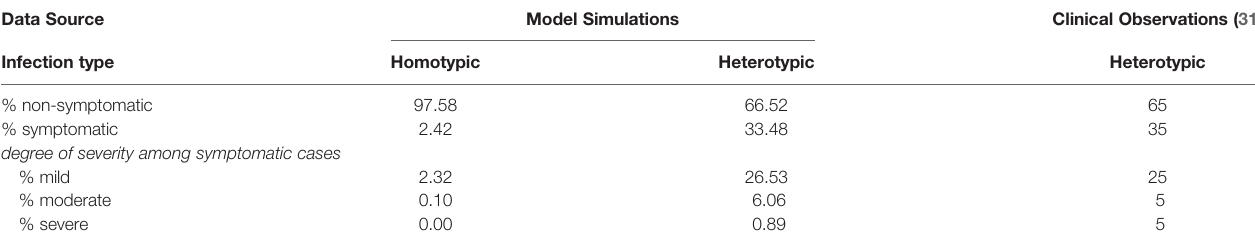
TABLE 1 | Average percentages of patients sorted by disease severity from both simulation (heterotypic and homotypic) and clinical